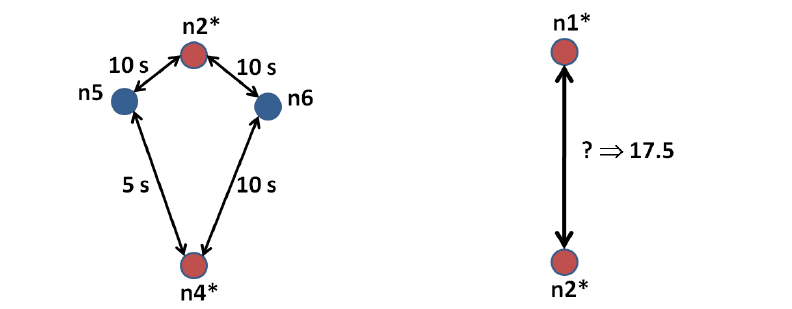
Figure 3. From travel times in the detailed representation ( left ) to the travel times in the aggregated representation ( right ).